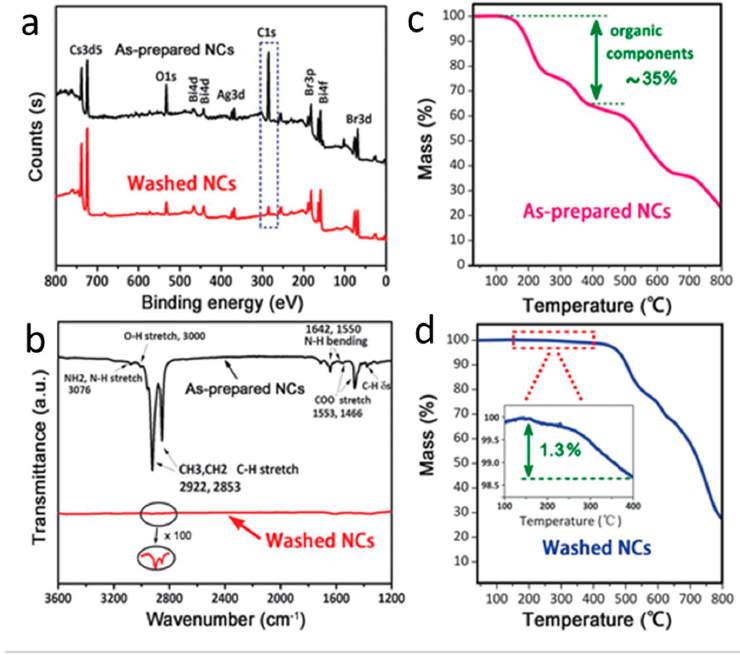
Figure 8. ( a ) XPS, ( b ) FTIR, and ( c , d ) TGA analysis of Cs 2 AgBiBr 6 before and after the